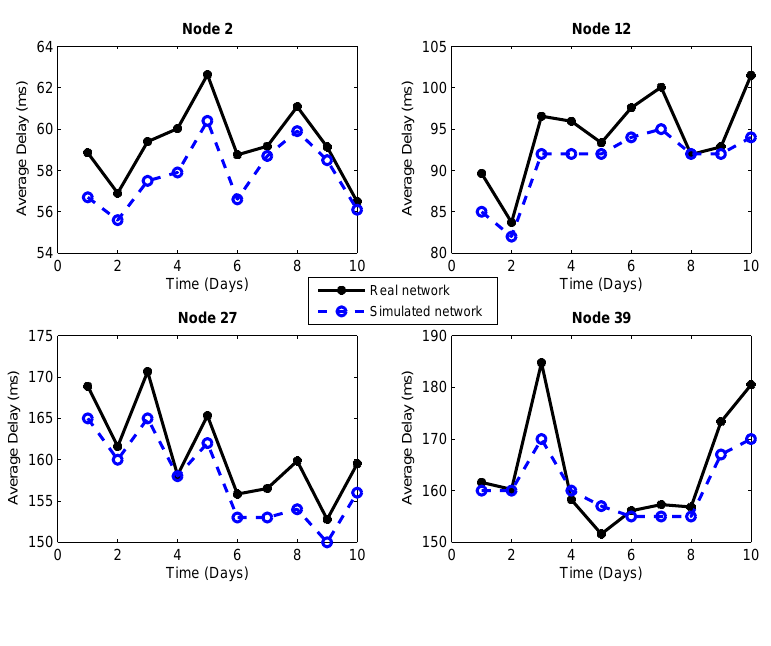
Figure 4. Average delay per day in source nodes.